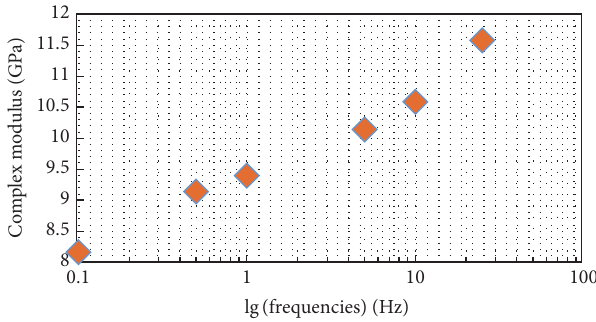
Figure 7: The dynamic modulus simulations under different load- ing frequencies.